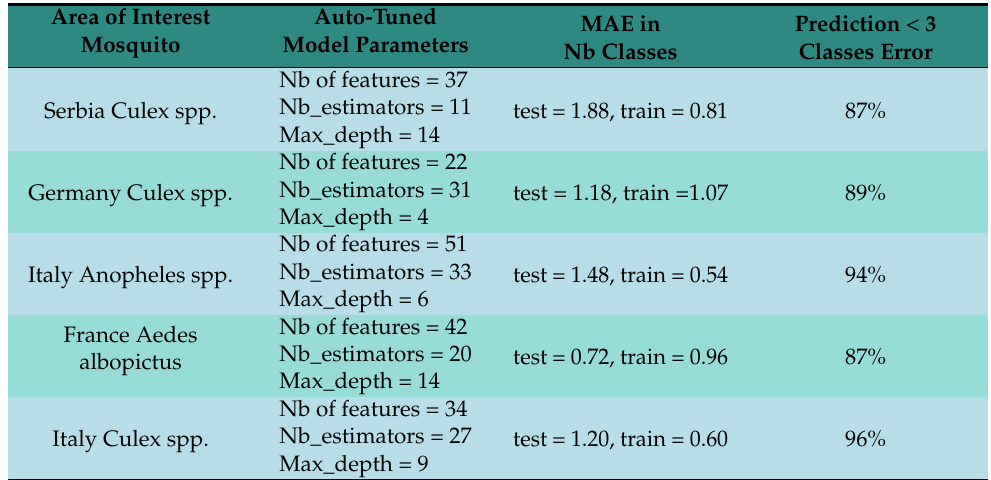
Table A2. MAMOTH’s pre-operational applications and performance per country using only EO